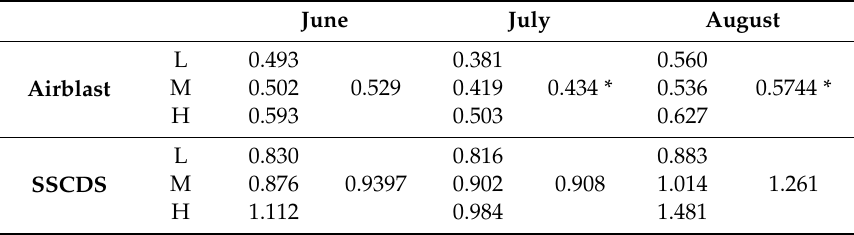
Figure 4. Least square means of the percent adaxial coverage (cm 2 ). Means shown for each of the sampled dates ( A ) 5 / 2 / 16, ( B ) 6 / 8 / 16, ( C ) 7 / 12 / 16, and ( D ) 8 / 8 / 16) and heights (L = 0.7 m, M = 1.4 m, H = 2.1 m). Error bars indicate (Tukey-Kramer) 95% confidence intervals. Di ff erent letters within a month indicate significant di ff erences among bars within a month. No significant di ff erences were detected in May (SSCDS system only). Table 3. Coe ffi cient of Variation of adaxial coverage (cm 2 ) for each date and height. Least square mean of each treatment, height, and date combination on the left and least square mean of the overall date and treatment combination to the right. Asterisks denote a significant di ff erence between months within a